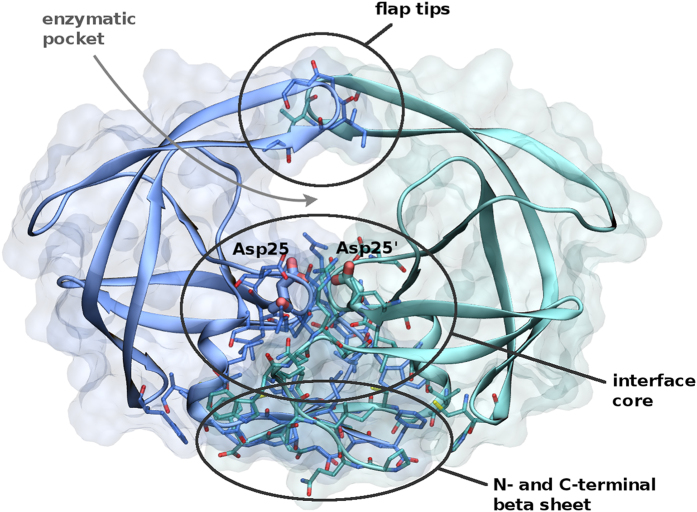
Crystallographic structure of the HIV-1 protease dimeric complex (pdb entry 1AID23).The enzymatic cavity and the three main regions forming the interface are indicated.